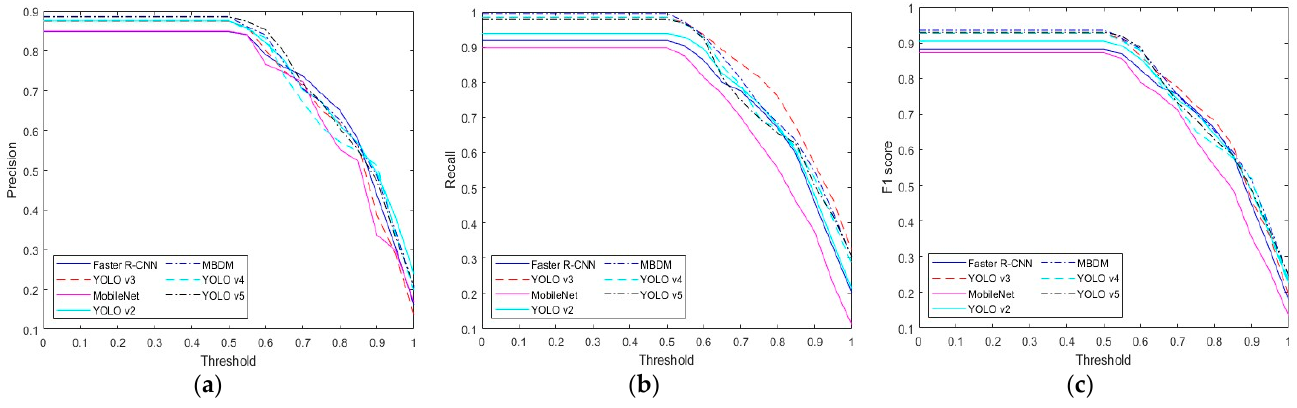
Figure 8. Performance comparison graph for each method according to IoU threshold in USD database: ( a ) precision, ( b ) recall, and ( c ) F1 score.